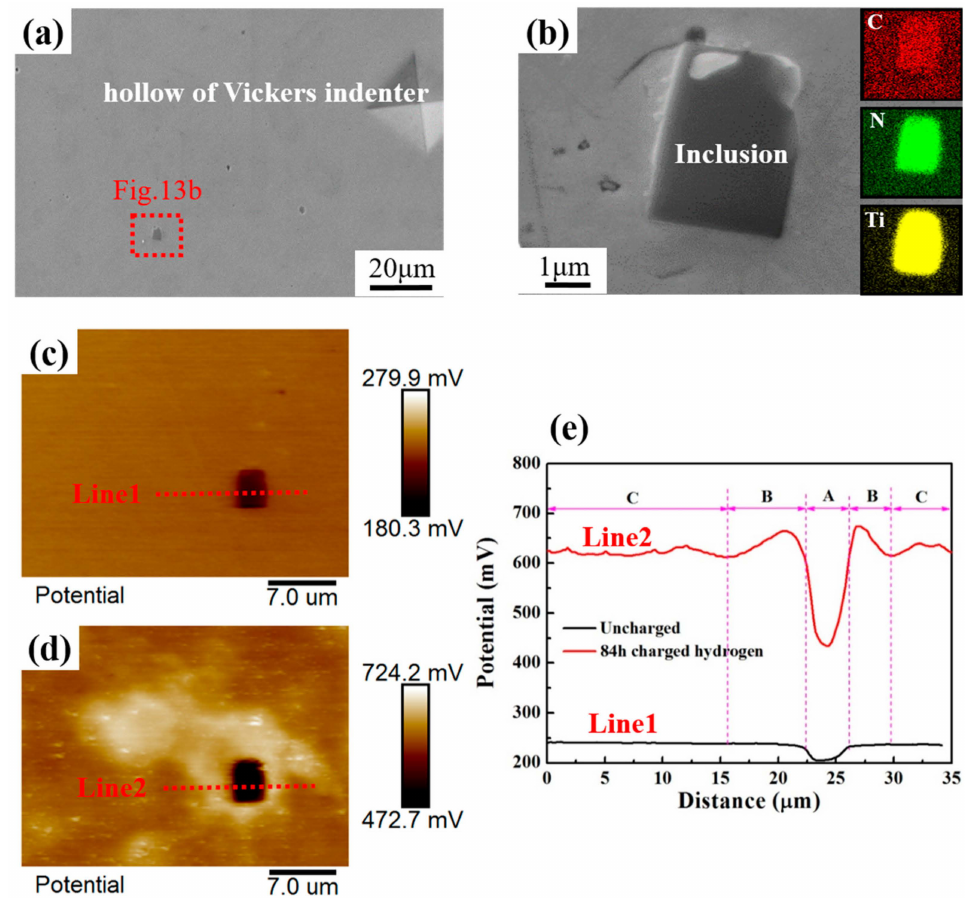
Figure 13. In-situ SKPFM. ( a ) and ( b ) SEM image and EDS mapping of the inclusions observed, potential images of uncharged ( c ) and 84 h charged ( d ) samples, and ( e ) potential curves of lines 1 and 2 . A represents the inclusion, B represents the matrix adjacent to the inclusions, and C represents the matrix away from the